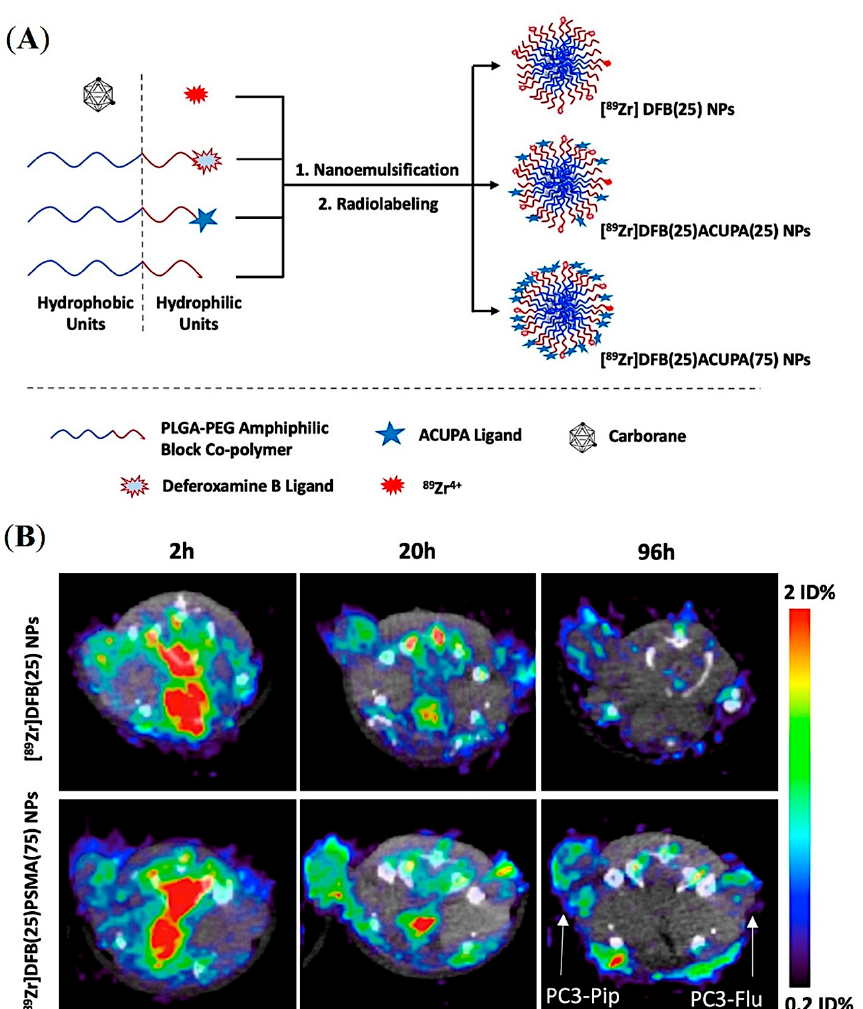
Figure 7. Design and preliminary evaluation of carborane-loaded, PSMA-targeted PLGA–PEG NPs for imaging and treatment of prostate cancer using BNCT. ( A ) Graphical presentation of carborane- loaded PLGA–PEG NPs radiolabeled with 89 Zr for targeted boron delivery. ( B ) Axial µ PET/CT imaging of mice bearing dual xenografts of PC3-Pip and PC3-Flu at different time points. Reprinted with permission from Ref [57]. Copyright 2021, American Chemical Society.